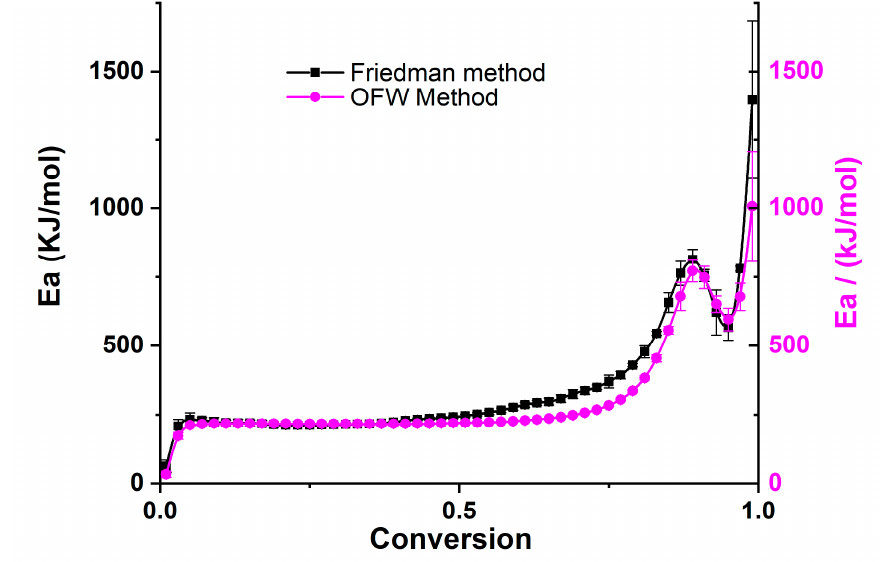
Figure 6. Activation energies calculated using Friedman analysis (black) and the Ozawa − Flynn − Wall method (magenta) under nitrogen.